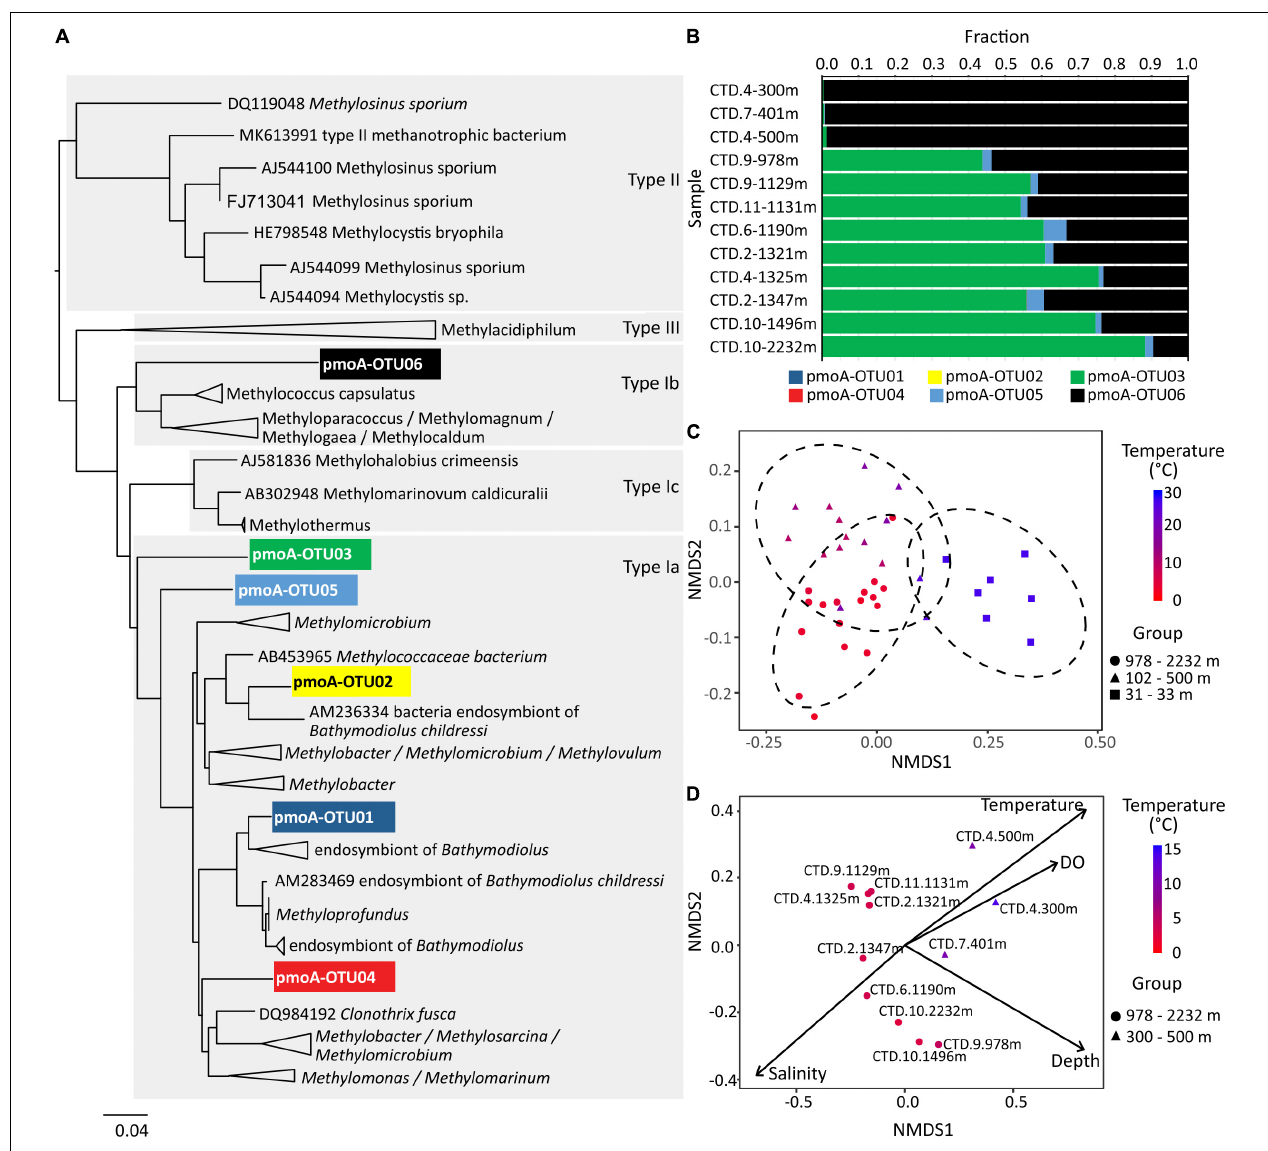
FIGURE 12 | The N-J tree (A) and relative abundances (B) of pmo A OTUs in water samples. Non-metric multidimensional scaling plot of beta diversity based on 16S rRNA gene amplicons in (C) and pmo A gene amplicons in (D) . In (C) the 95% confidence ellipses circumscribe the samples from different water depths, and in (D) vectors represent environmental variables that significantly correlated with the ordination space with length corresponding to the strength of the